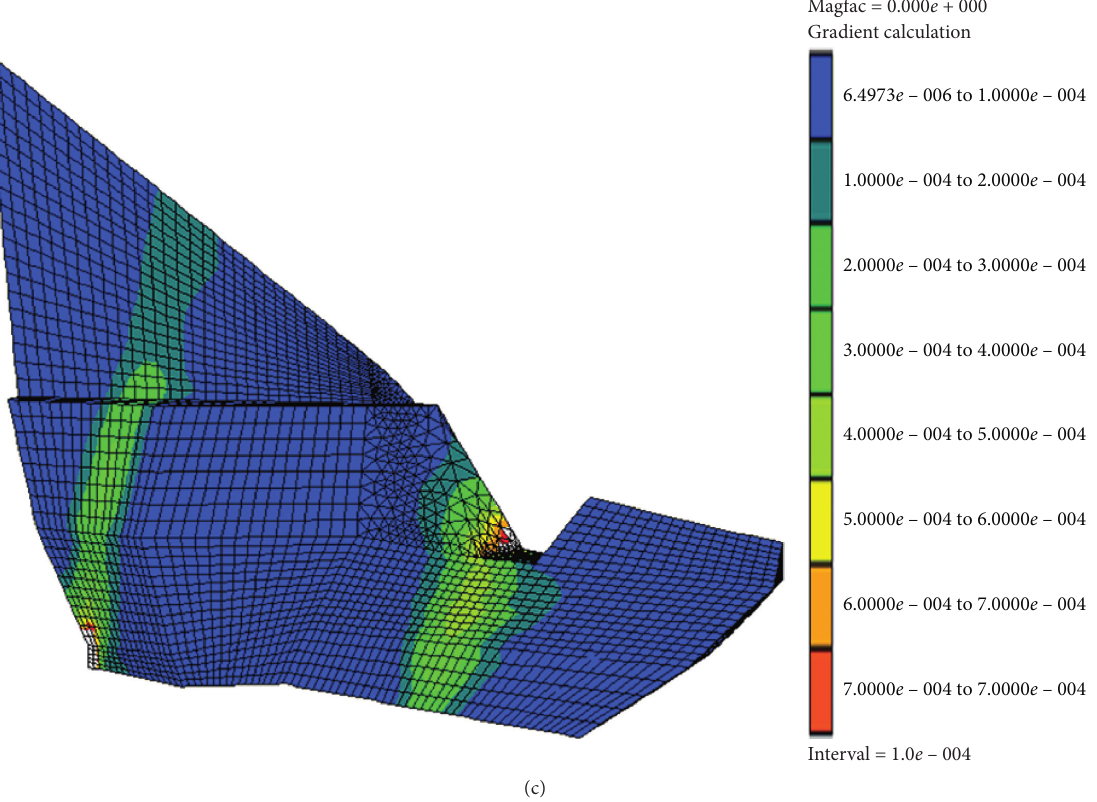
Figure 14: Evolution of incremental shear strain of the potential failure region with the SRF, (a) SRF � 1.10, (b) SRF � 1.26, (c) SRF �